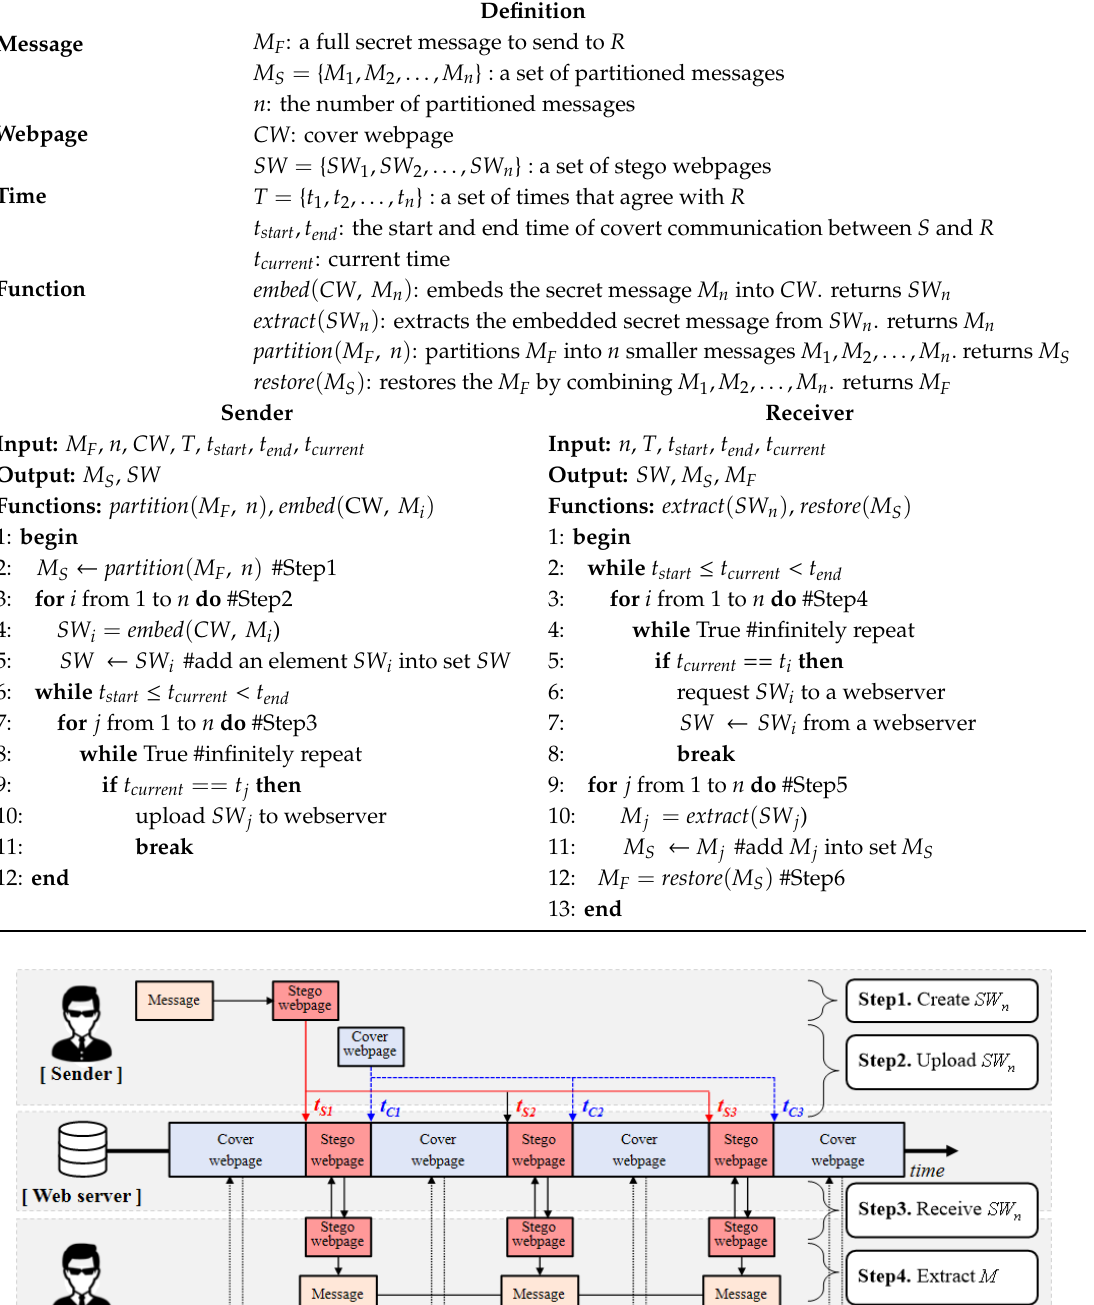
Algorithm 1 TDOA-C (Time-Based Dynamic Operation Algorithm for Hiding Capacity) Definition